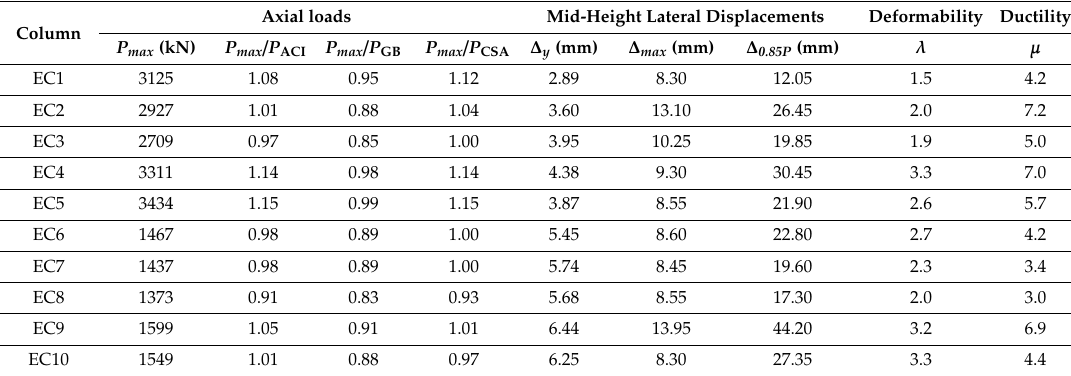
Figure 7. Yield point determined by the Park et al. method. Table 4. Summary of test results.